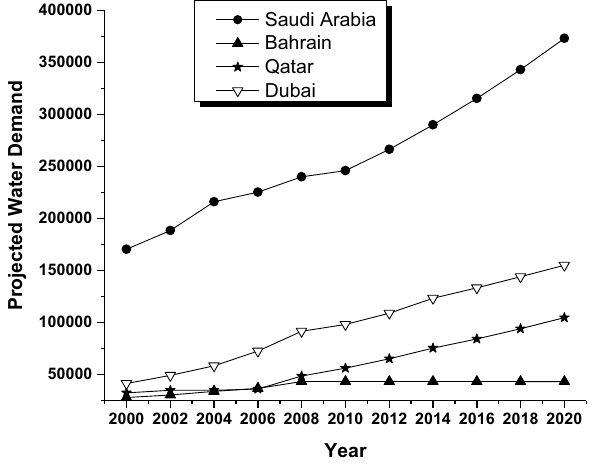
Fig. 2 Projected water demands in few GCC countries, millions of imperial gallons, 2000–2020. [Source: Economist Intelligence Unit Limited